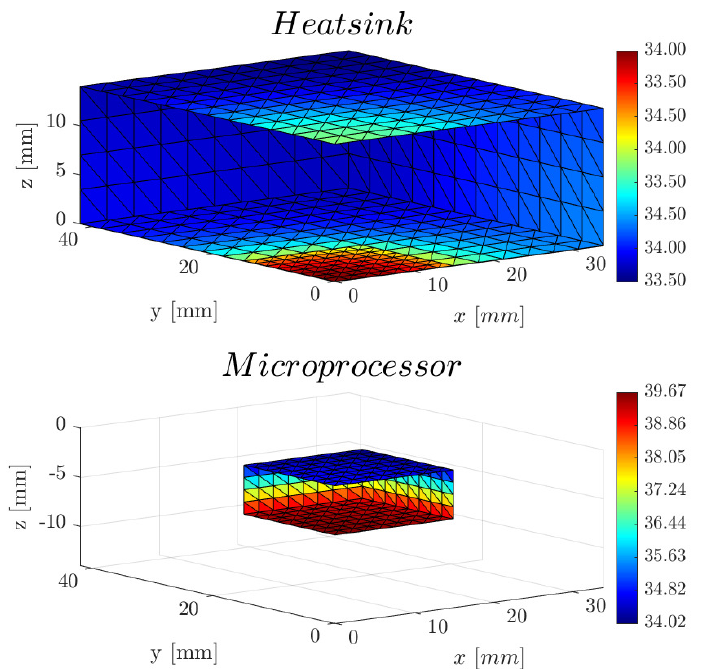
Figure A8. Temperature distribution θ [ ◦ C] of the boundary of the microprocessor and the heatsink when a thermal grease fills the interface